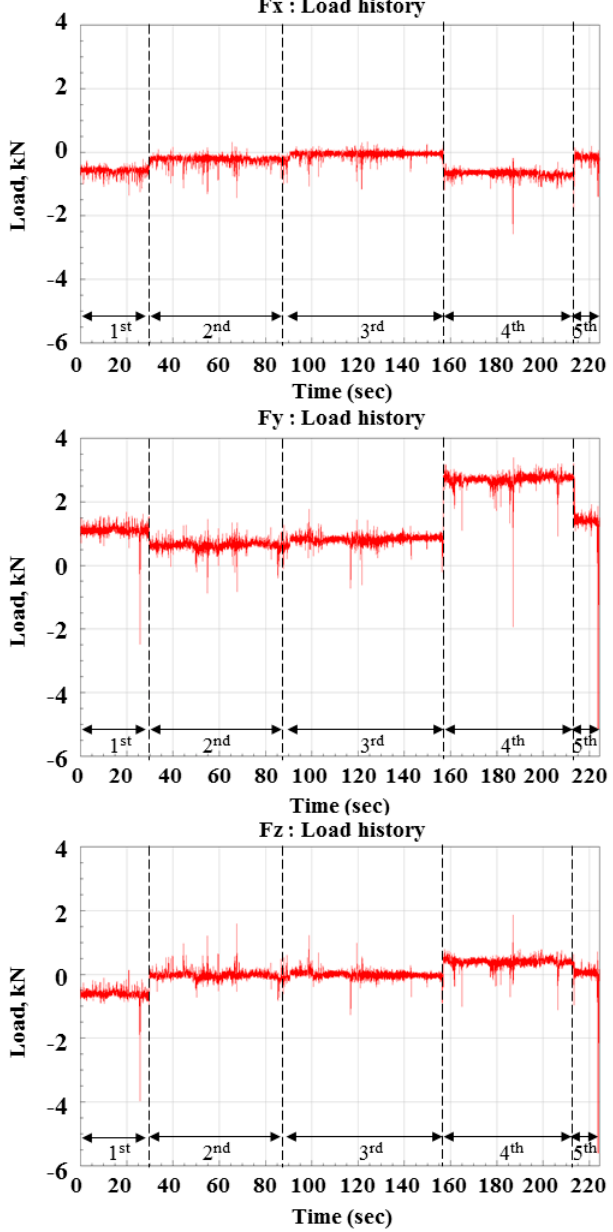
Figure 6. Load reconstruction for disk harrow assembly in all directions.